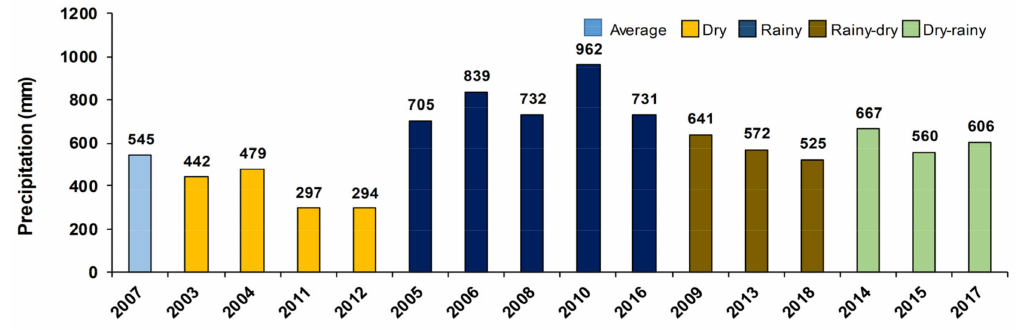
Figure 2. Total annual precipitation in the investigated periods